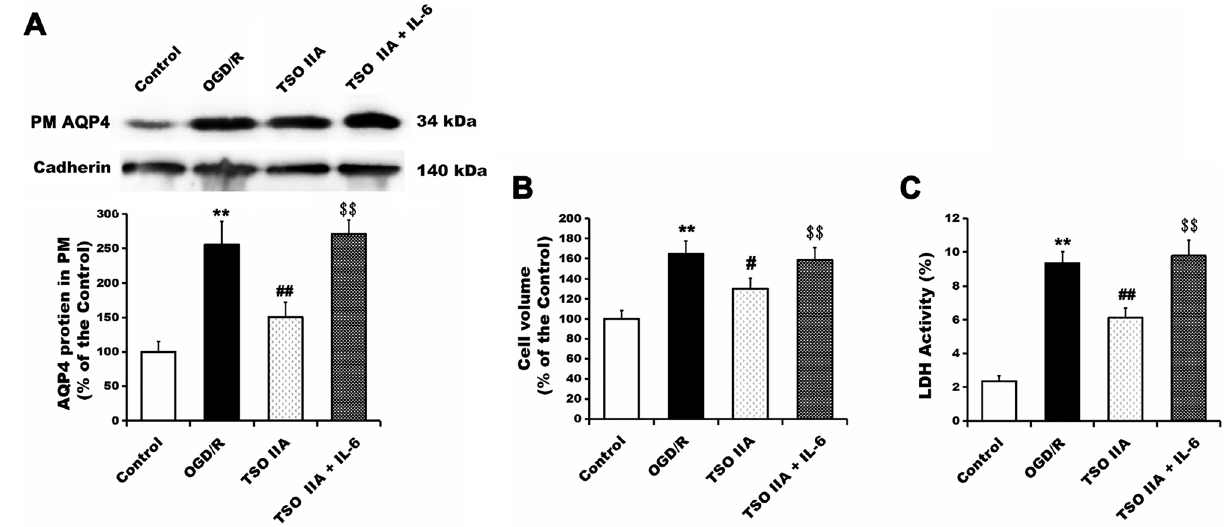
Figure 5. Role of IL-6 in TSO IIA-mediated inhibition of AQP4 overclustering in the cytoplasm and astrocyte swelling after OGD/R. ( A ) AQP4 expression in the plasma membrane after OGD/R in cells subjected to vehicle, TSO IIA, or both TSO IIA and IL-6 ( n = 3 independent cultures). ( B and C ) Cell volume and LDH activity after OGD/R was detected in cells subjected to vehicle, TSO IIA, or both TSO IIA and IL-6 ( n = 3 independent